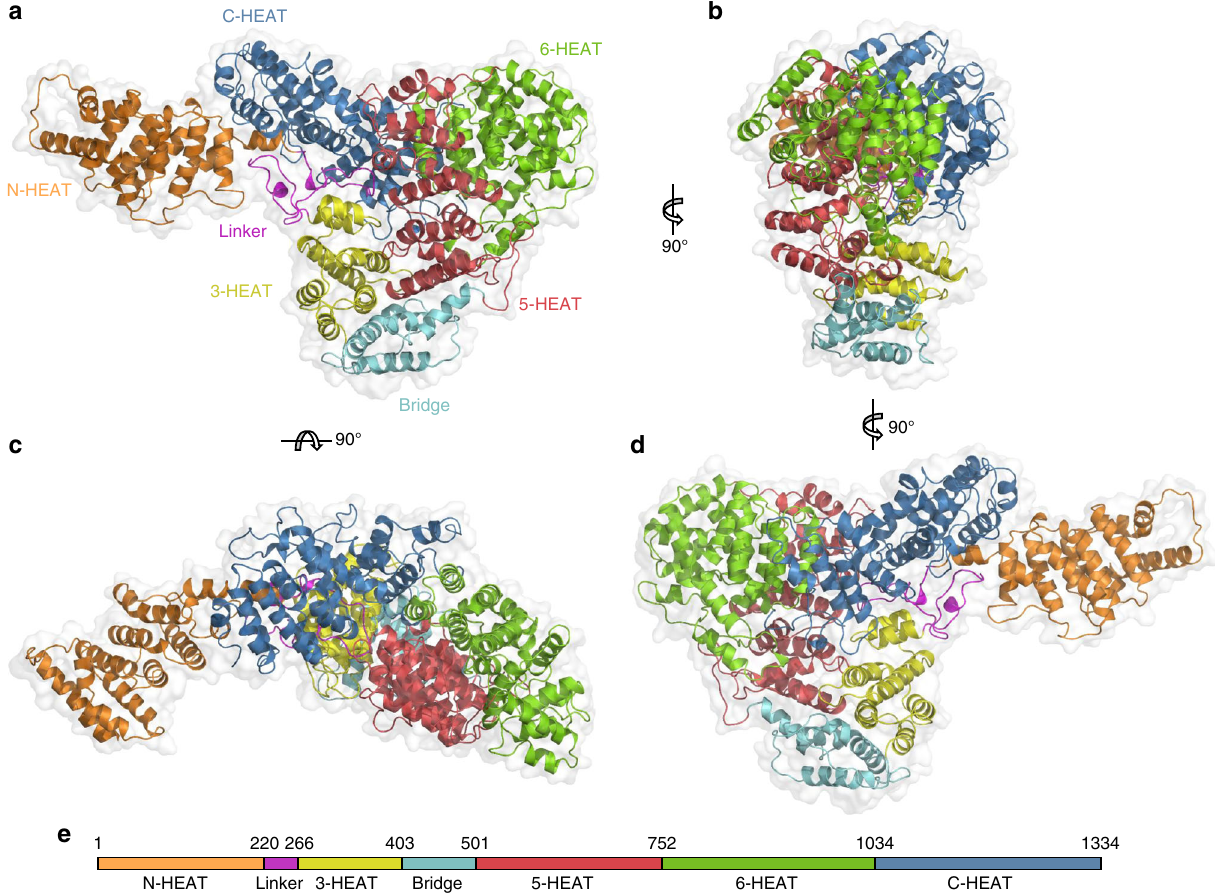
Fig. 1 Architecture of MED23. a − d The overall structure is shown as a translucent surface. The atomic model is shown in ribbon representation, with domains color-coded as follows: MED23 N-HEAT domain, orange; MED23 linker, pink; MED23 3-HEAT domain, yellow; MED23 bridge domain, cyan; MED23 5-HEAT domain, red; MED23 6-HEAT domain, green; MED23 C-HEAT domain, blue. ( a − d ) show different orientations of the complex, as indicated. e Schematic of the domain organization of